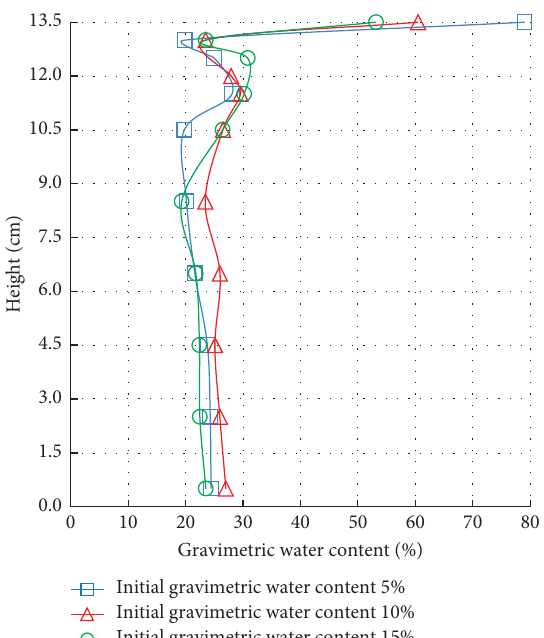
Figure 13: Water content distribution of different initial water